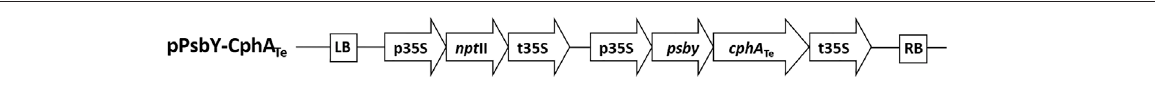
FIGURE1| Mapofthenucleartransformation vectorforconstitutive,plastidicexpression ofthecyanophycinsynthetase. cphA Te:cyanobacterialcodingregionof theCP-synthetasefrom T.elongatus BP-1, psby :peptide of the integral protein of photosystemII, p35S:constitutive cauli fl ower mosaic virus (CaMV) 35S promoter; t35S: CaMV terminator, npt II:coding region of neomycin phosphotransferase gene, LB and RB, left and right borders of A.tumefaciens binary vector (Hühns et al.,